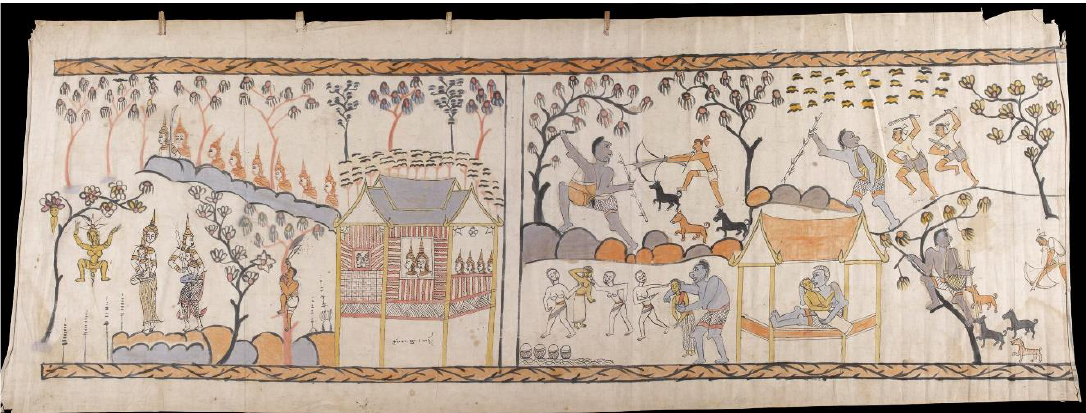
Figure 7. Vessantara Jātaka scroll, Walters Museum. Thai (Artist). PERIOD: 1st half 20th century (Bangkok). MEDIUM: pigments on cloth (Painting & Drawing). ACCESSION NUMBER: 35.288. MEASUREMENTS: H: 96 1/16 × L: 36 in. (244 × 91.5 cm).